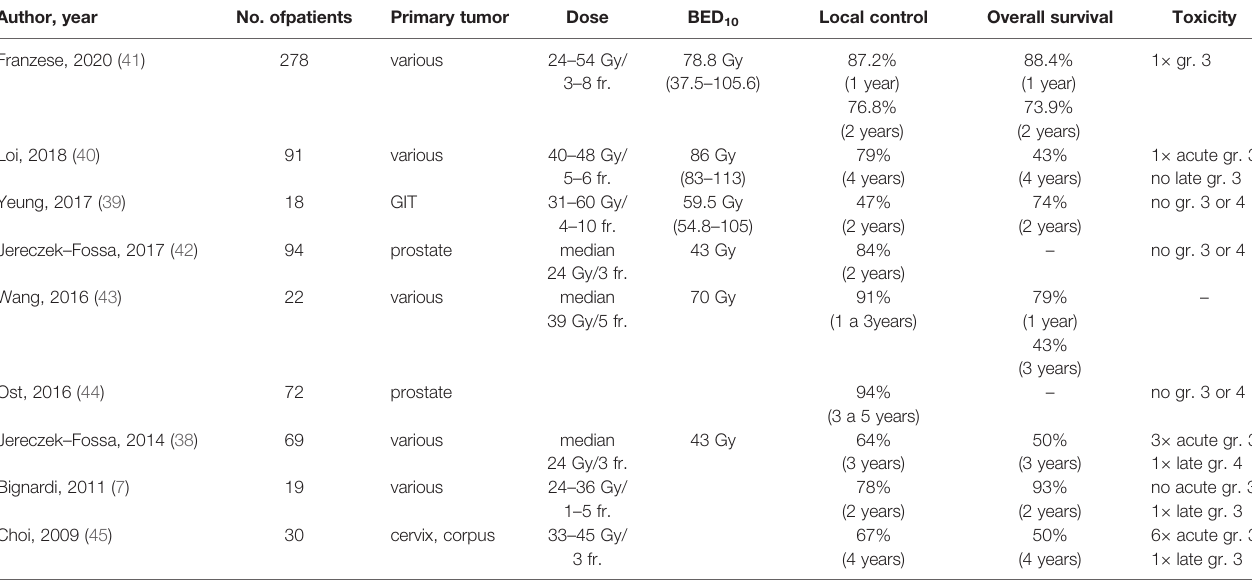
TABLE 4 | Selected recent SBRT studies evaluating the treatment of lymph node